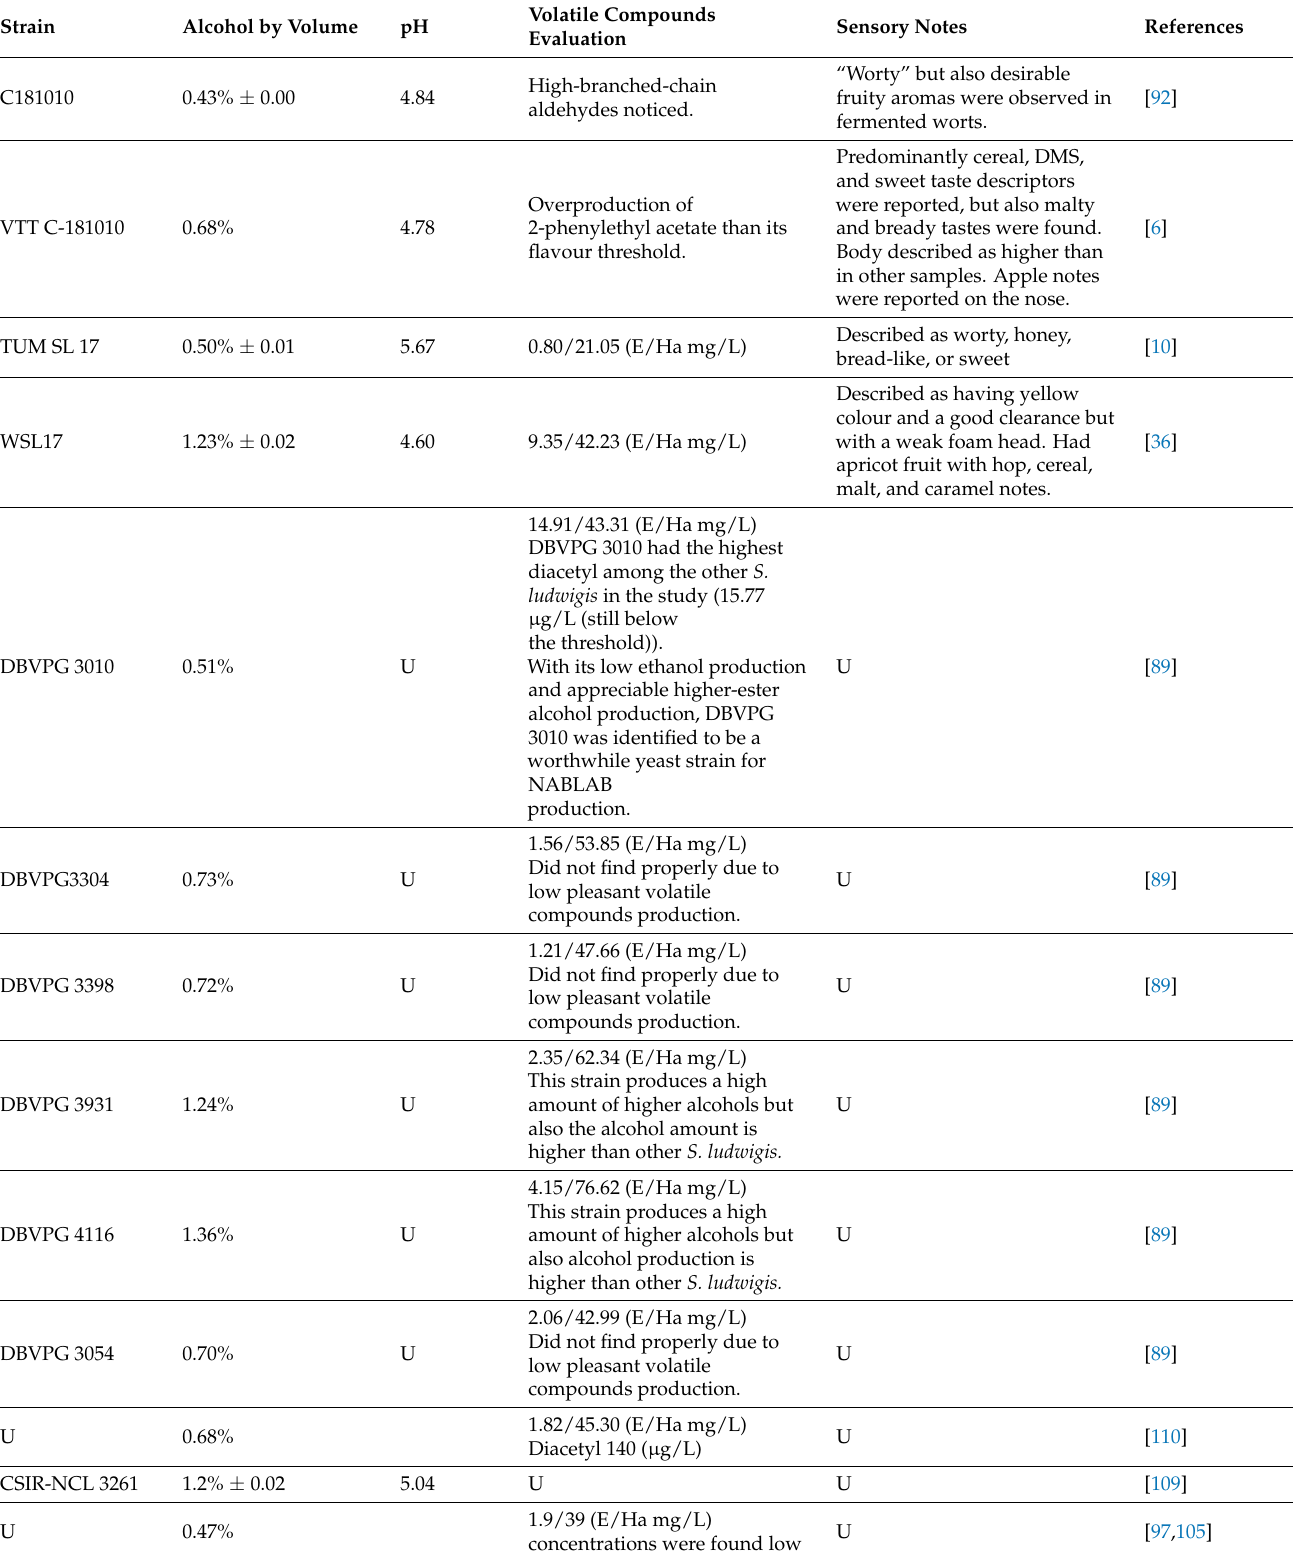
Table 2. Comparison of the suitability and aroma potential of some Saccharomycodes ludwigi yeast strains.